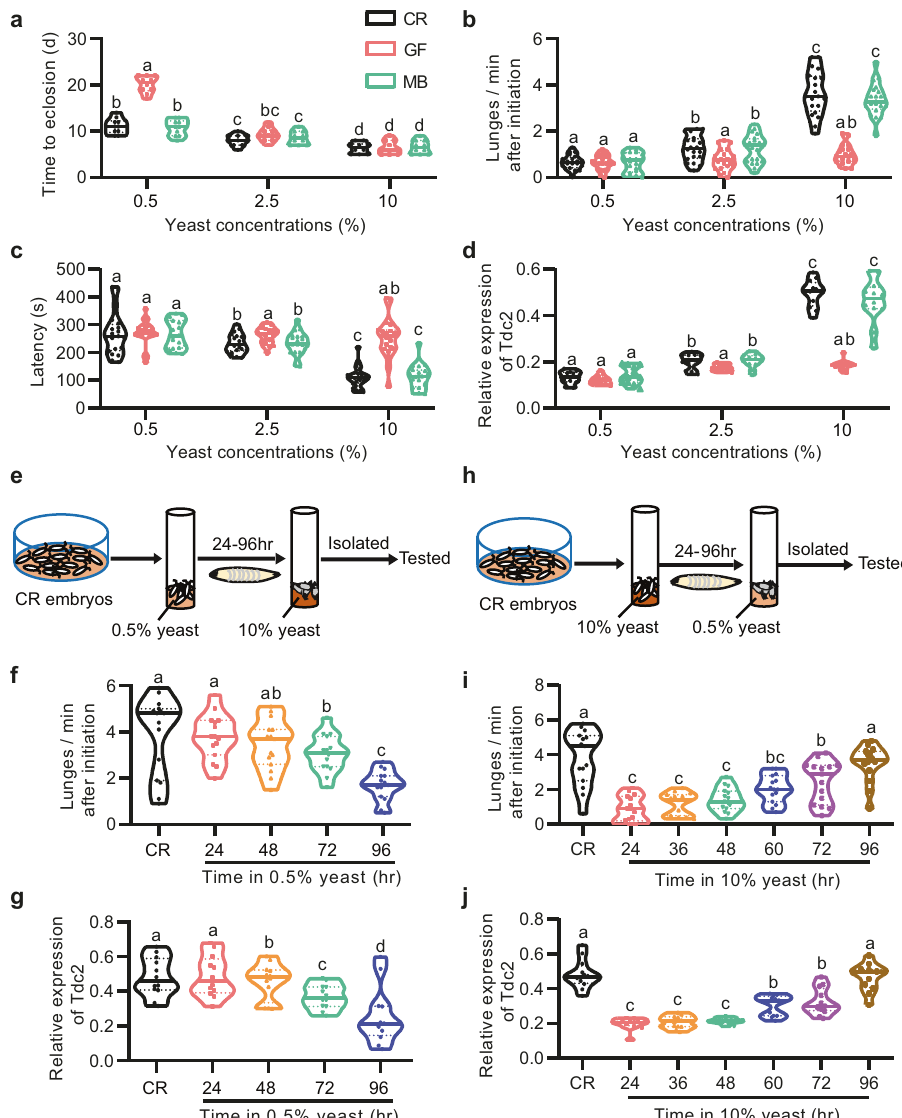
Fig. 6 Microbiome interacts with diet to modulate aggressive behaviors. a The developmental time to eclosion of CR, GF, and MB fl ies raised in food medium with different yeast concentrations (0.5, 2.5, and 10%). n = 10 vials for each. b , c Lunging frequency ( b ) and fi ghting latency ( c ) of CR – CR, GF – GF, and MB – MB males raised in food medium with different yeast concentrations. n = 20 for each. d Relative expression of Tdc2 mRNA in CR, GF, and MB fl ies raised in food medium with different yeast concentrations. n = 12 based on three replicates for each. e Experimental setup to assess the impact of nutrition on aggression by transferring larvae from poor nutrition food to rich one at different developmental stages. f Lunging frequency of adult males after above manipulation. n = 15 for each. g Relative expression of Tdc2 mRNA in adult males after above manipulation. n = 12 for each. h Experimental setup to assess the impact of nutrition on aggression by transferring larvae from rich nutrition food to poor one at different developmental stages. i Lunging frequency of adult males after above manipulation. n = 15 for each. j Relative expression of Tdc2 mRNA in adult males after above manipulation. n = 12 based on three replicates for each. For all variables have different letters, they are signi fi cantly different ( p < 0.05). If two variables share a letter, they are not signi fi cantly different ( p > 0.05). Kruskal – Wallis test followed by Dunn ’ s multiple comparisons